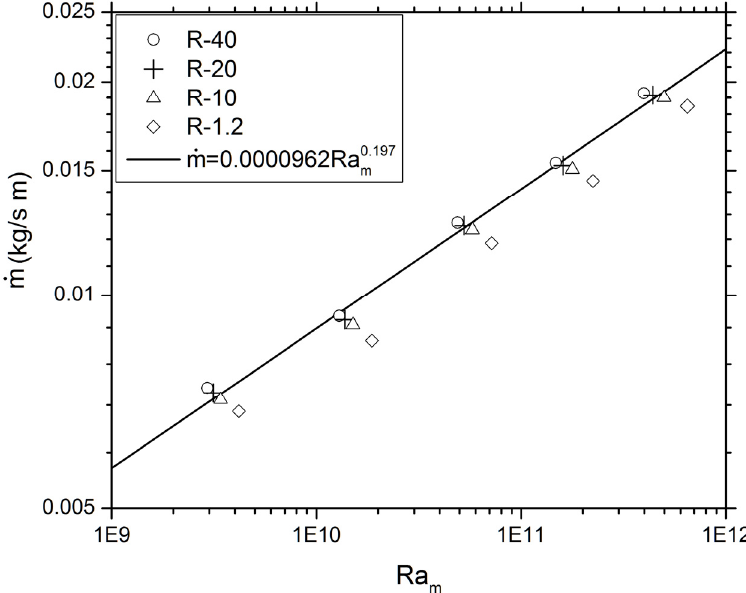
Figure 9. Correlation for ventilating mass flow rate compared with numerical data.